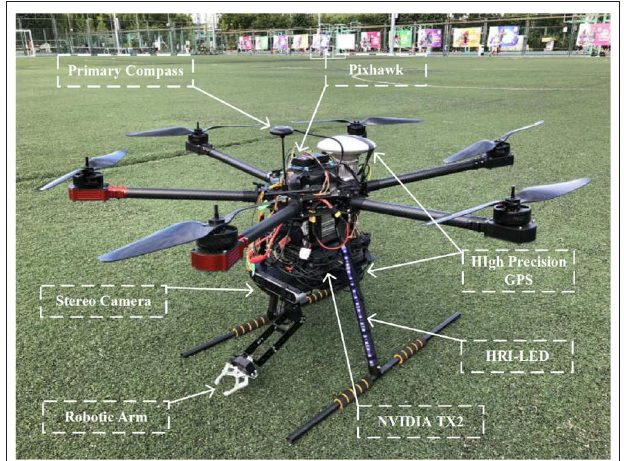
FIGURE 11 | Interaction initiation. Written informed consent for publication was obtained from the individuals in this